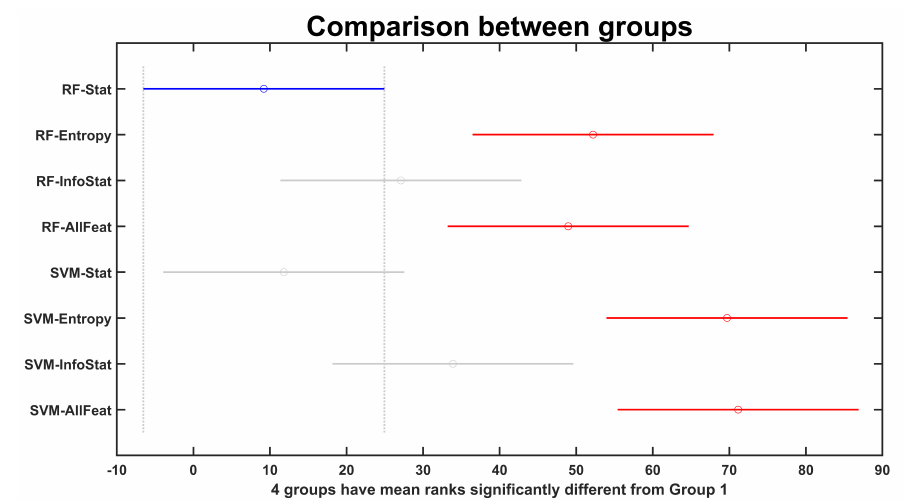
Figure A1. Kruskal–Wallis comparison between the machine learning models tested. The plot shows several combinations of features calculated from the channel A2 recorded from the CP. There are statistical significant differences between the groups labeled with red and the group labeled with blue, between the groups SVM-Entropy and SVM-AllFeat and the groups labeled with blue and gray. In general there are statistically significant differences, when the projection of the horizontal lines of a group over the horizontal axis does not have any interception with the projection of another group.